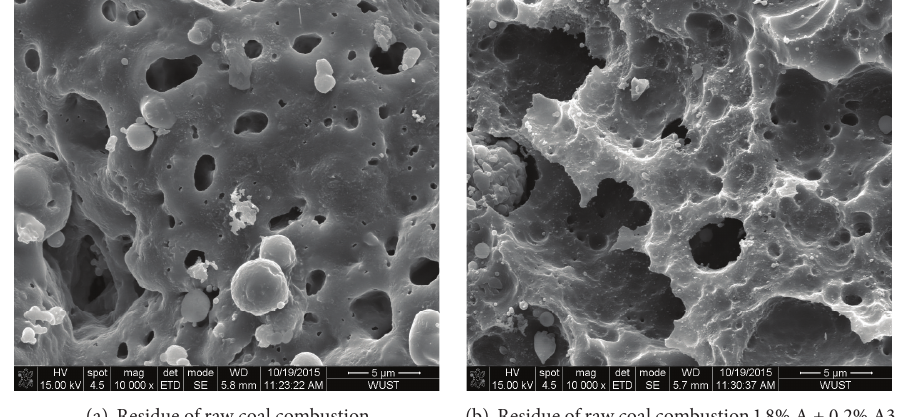
Figure 8: The SEM images of coal combustion residues.